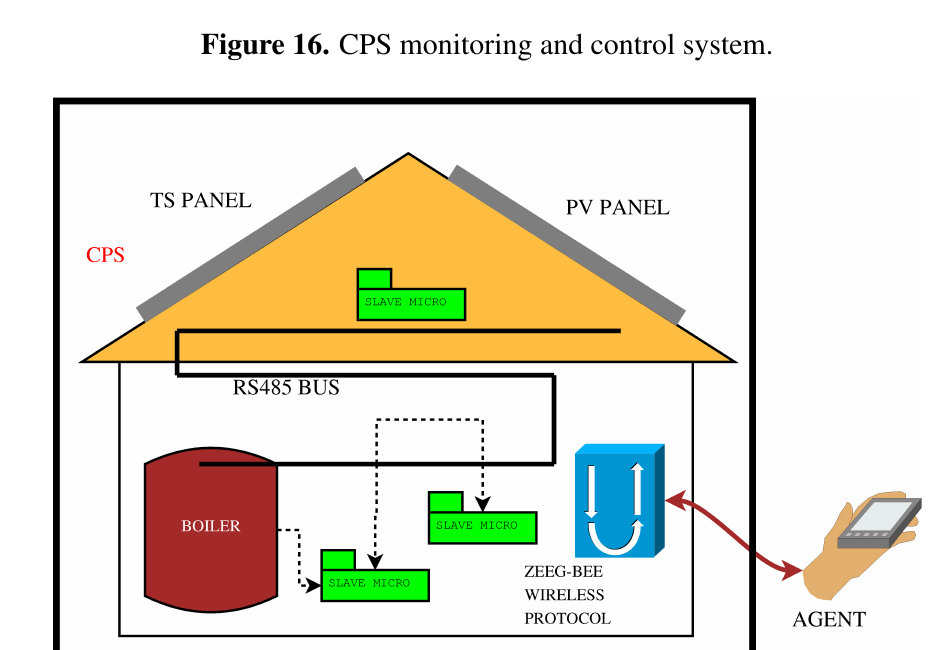
Figure 16. CPS monitoring and control